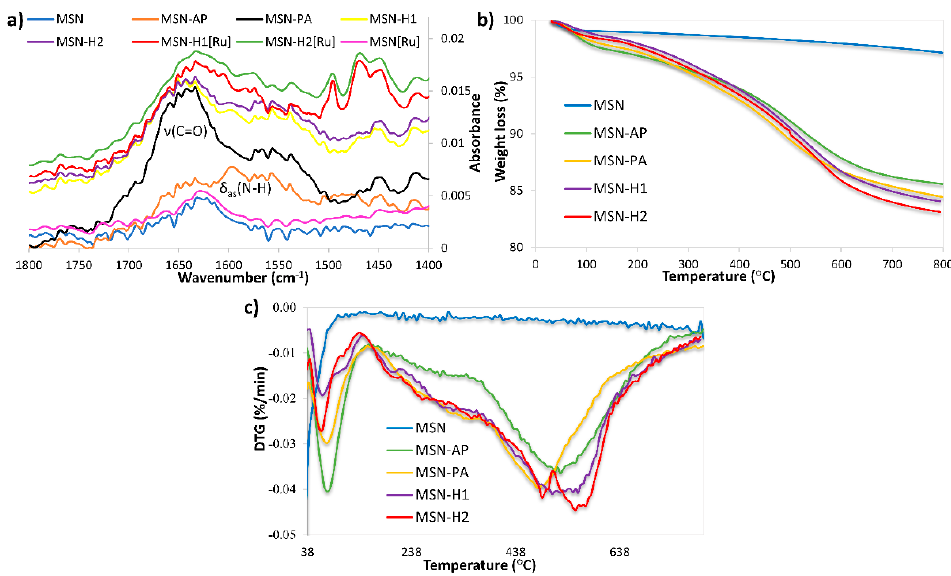
Figure 3. ( a ) FTIR spectra and ( b , c ) thermogravimetric analysis of the prepared materials.